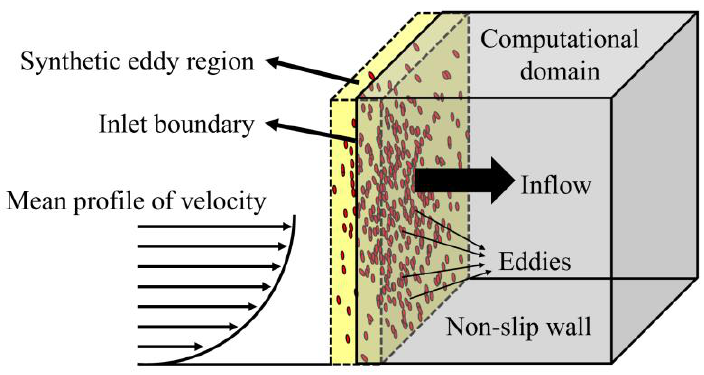
Figure 2. Schematic diagram of the synthetic vortex region.